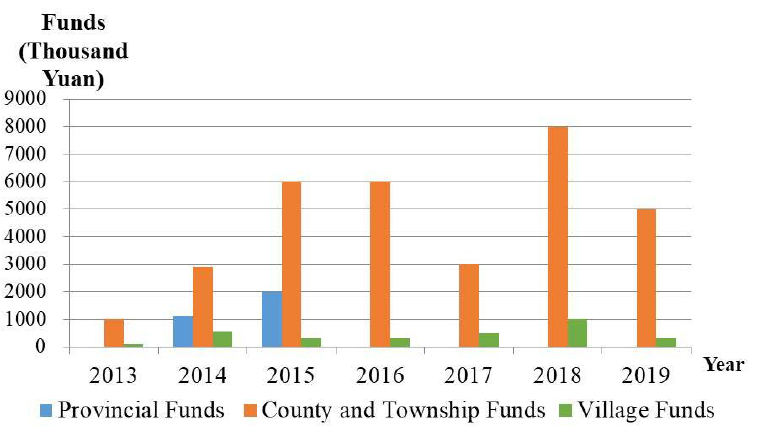
Figure 5. Funds from each administration level of Baiyankeng village (2013–2019) (data provided by the village